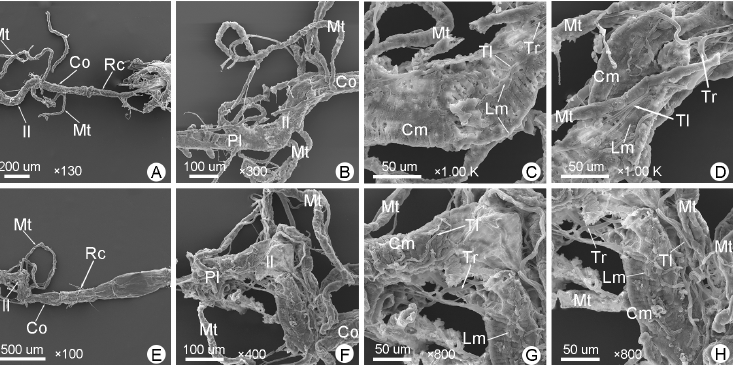
Figure 7. The hindguts of M . ( O .) chinensis (males ( A – D ), females ( E – H )): ( A , E ) general view of the hindgut; ( B , F ) pylorus (Pl) and general view of ileum (Il); ( C , G ) anterior ileum; ( D , H ) posterior ileum. Cm: circular muscle, Co: colon, Lm: longitudinal muscle, Mt: Malpighian tubule, Rc: rectum, Tl: tracheole, Tr: trachea. Insects 2023 , 14 , x FOR PEER REVIEW